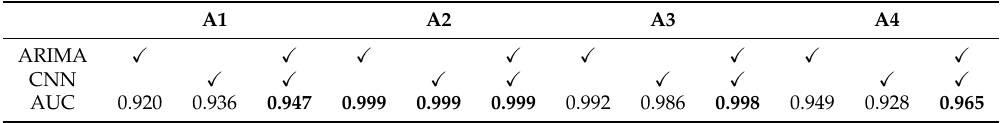
Table 3. Ablation study on the Yahoo Webscope dataset.